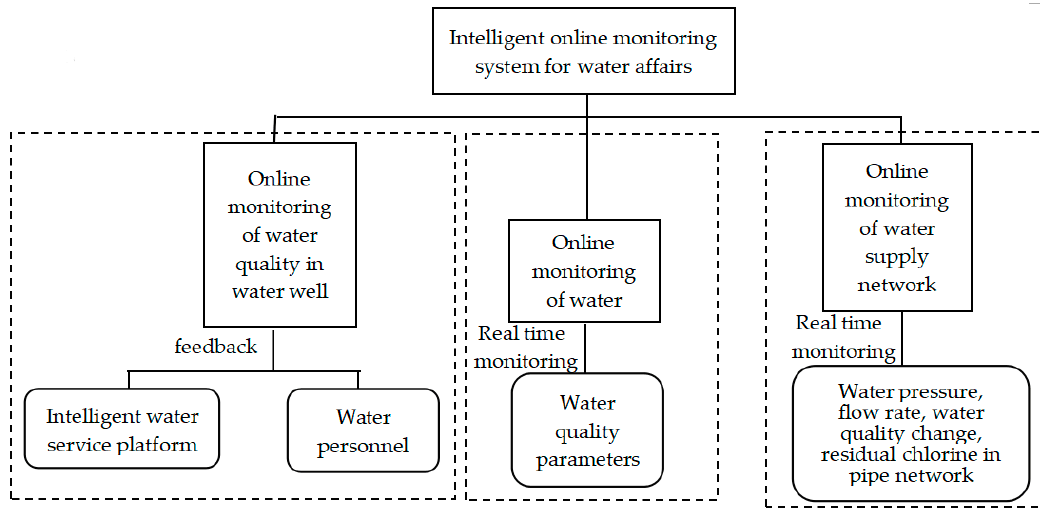
Figure 9. Flow chart of online monitoring system for intelligent water management.